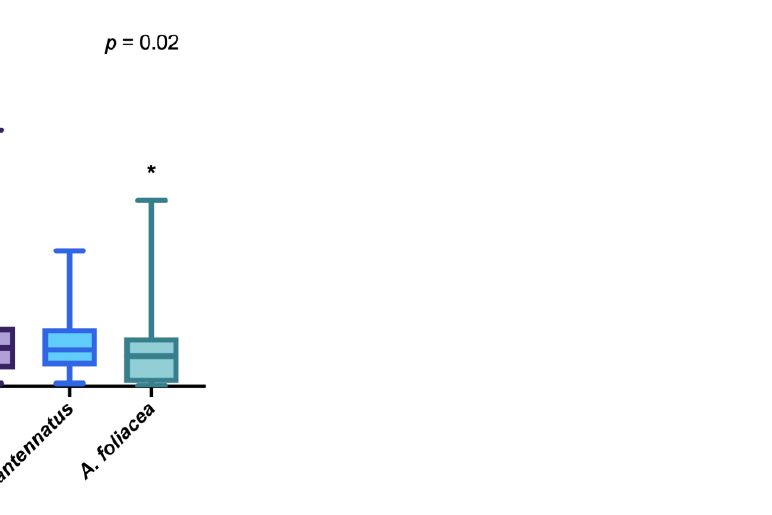
Figure 6. Microparticles size comparison between the three species analyzed. * indicates significant differences p < 0.05.